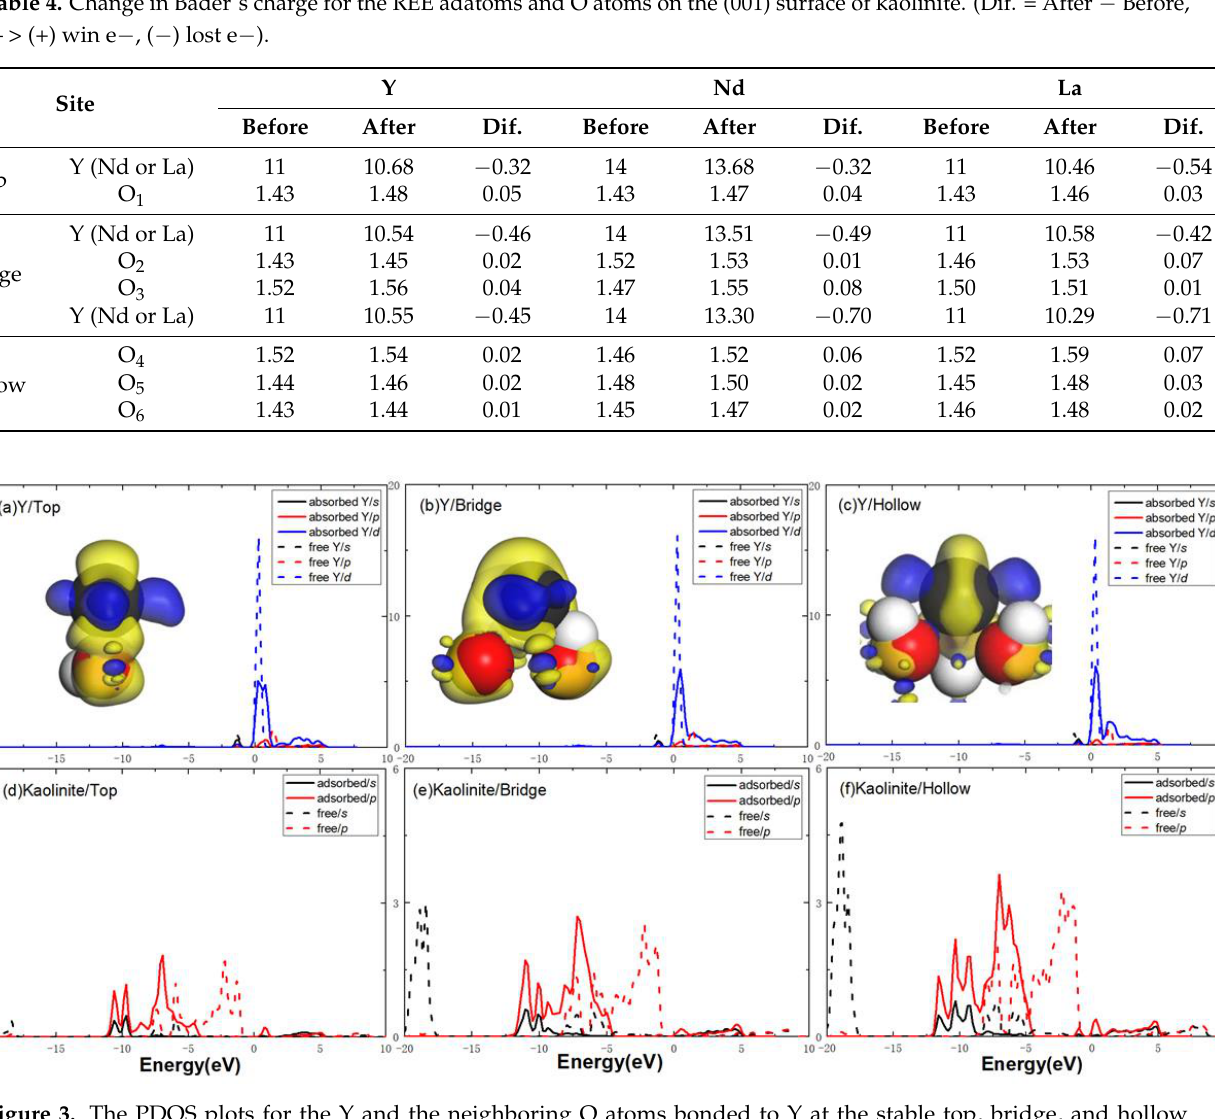
Figure 3. The PDOS plots for the Y and the neighboring O atoms bonded to Y at the stable top, bridge, and hollow adsorption sites on (001) surface: ( a – c ) free and adsorbed Y at the top, bridge, and hollow adsorption site, respectively; ( d – f ) clean and adsorbed kaolinite (001) surface at the top, bridge, and hollow adsorption site, respectively. The insets show the side view of electron density difference for the Y at the top, bridge, and hollow adsorption sites.